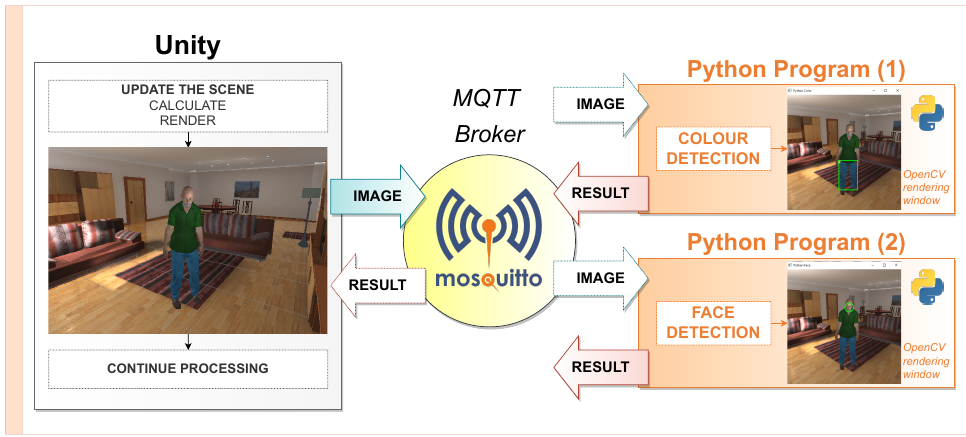
Figure 12. Parallel execution of the colour and face detection algorithms in two Python programs communicated via